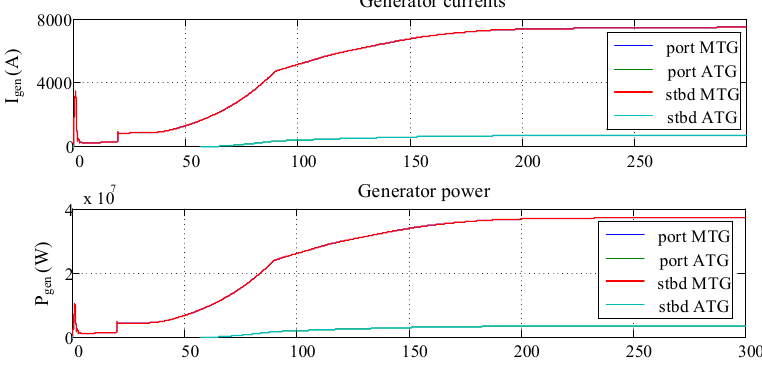
Figure 5. Case 1 generator current and power.